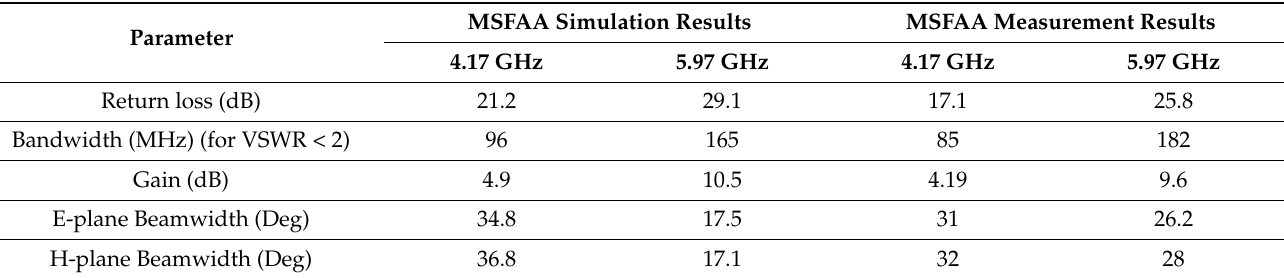
Table 2. Comparison of simulation and measured results of four-element